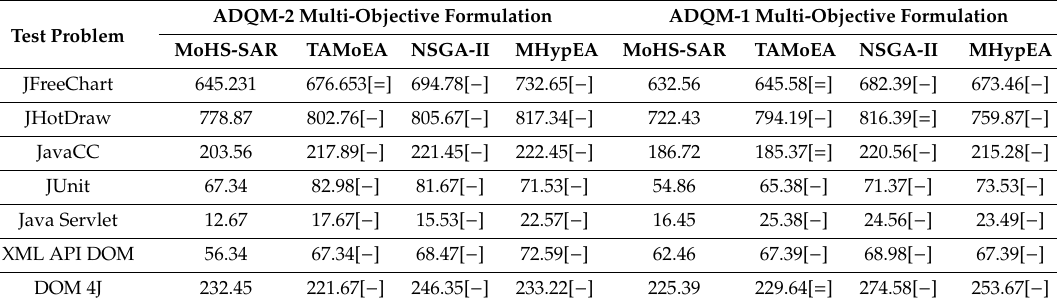
Table 5. Coupling as an assessment criterion.